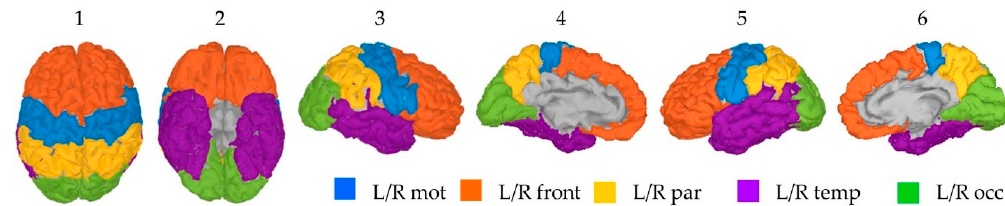
Figure 2. Anatomical location of the selected ten region for a given participant—1: frontal, 2: bottom, 3: right external, 4: left internal, 5: left external and 6: right internal view.